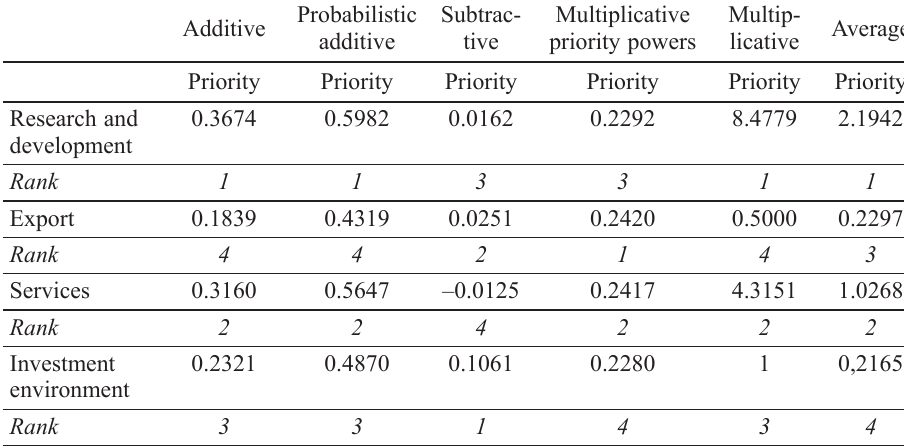
Table 15. Final results of